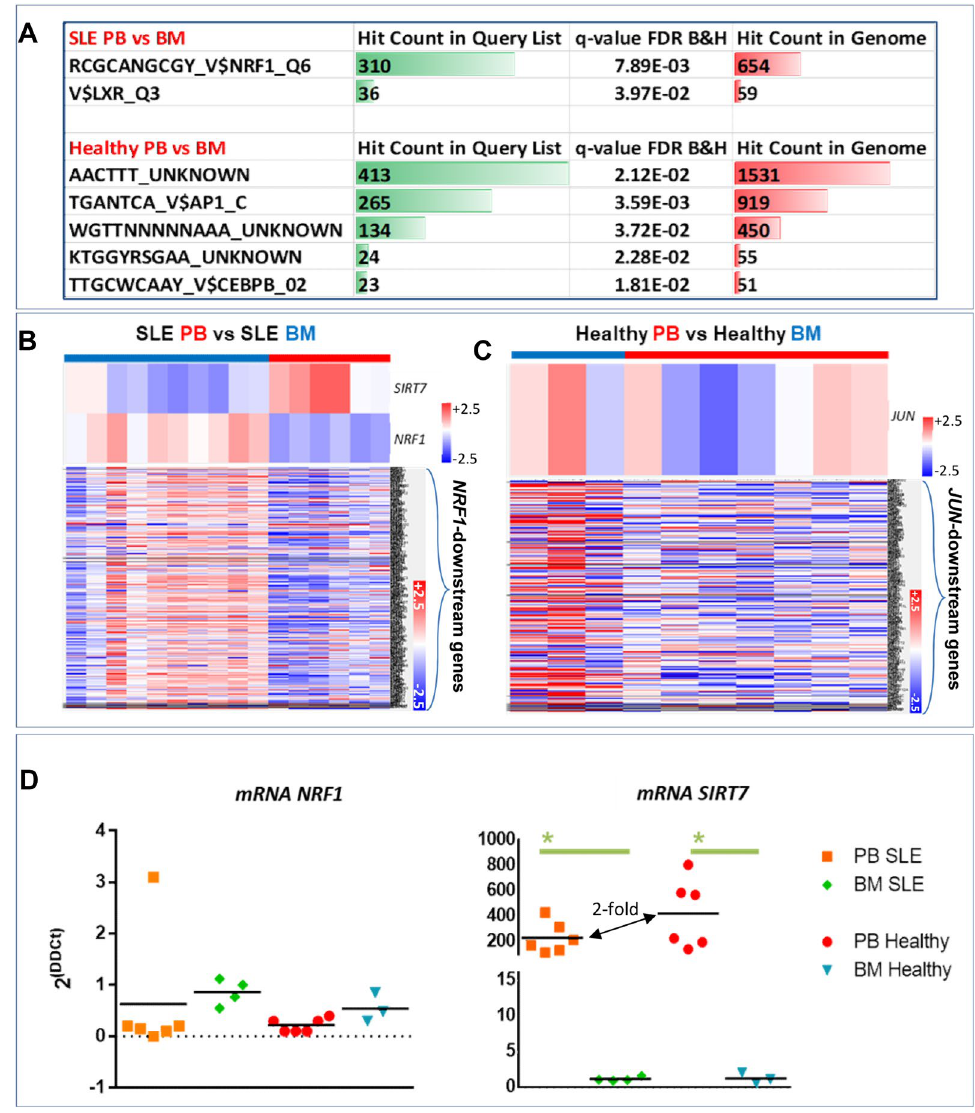
Figure 3. The NRF1-SIRT7 transcriptional signature is altered in PB CD34 + progenitors. ( A ) A table indicating the predicted TF binding sites (Toppgene™ software) based on the DEG input list. In the SLE PB versus BM comparison the NRF1 and LXR TFs were identified, while in the Healthy PB versus BM comparison, AP1 ( JUN ) and CEBPB were identified along those with unknown TF bindings site motifs. ( B ) Heatmaps of SIRT7 and NRF1 expression in SLE PB and SLE BM, along with 310 DEG that are affected by NRF1 expression. ( C ) Heatmaps of JUN expression in Healthy PB and Healthy BM, along with 265 DEG that are affected by JUN expression. ( D ) Real-time PCR graphs for NRF1 (ENST00000353868.5, ENST00000393230.6 isoforms) and SIRT7 (ENST00000575360.5, SIRT7-209, non-sense mediated decay) in all four groups. The expression of NRF1 was not statistically different in any of the four groups, albeit there was a trend of lower expression in the SLE PB. In contrast, SIRT7 expression was vastly and significantly elevated in PB CD34 + progenitors, in comparison to BM CD34 + progenitors. One-way ANOVA with Bonferroni’s posthoc test, * p < 0.05, n =